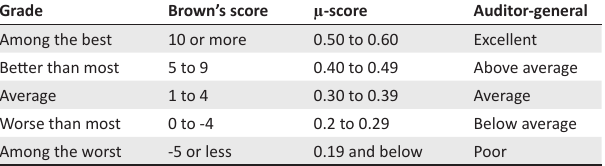
TABLE 3: Comparison of financial condition index with Brown’s 10-point score.